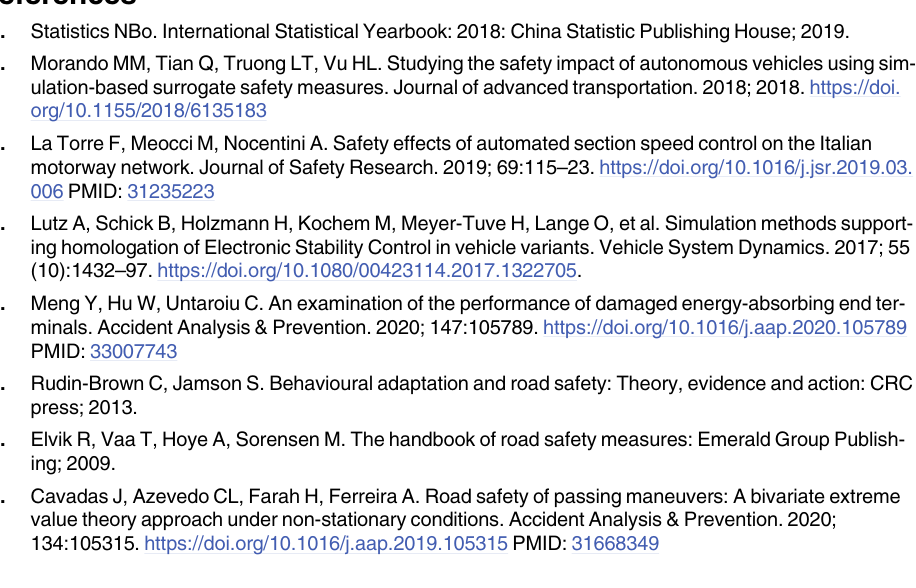
S2 Table. 1452 association rules of fatal